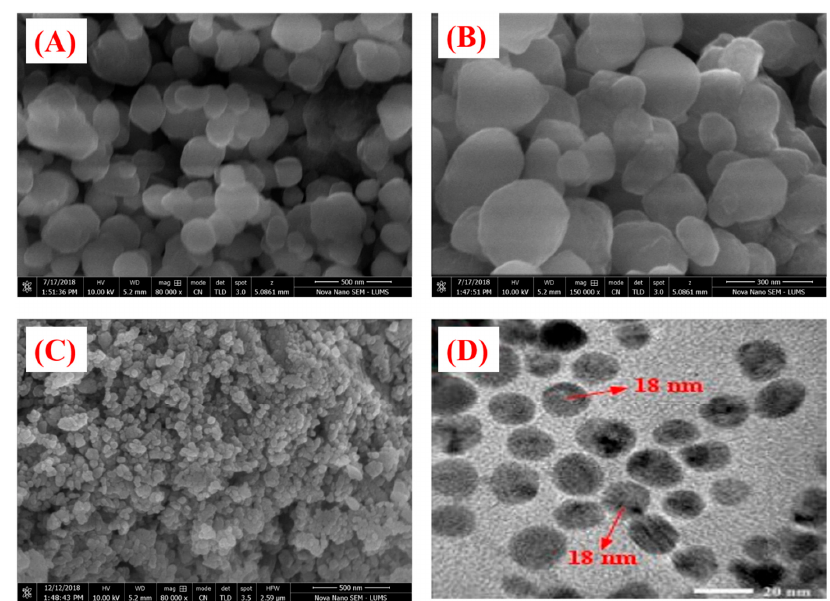
Figure 4. SEM and TEM images of Geranium wallichianum mediated ZnONPs using zinc nitrate as a precursor ( A – C ) HR-SEM images ( D ) TEM image. Biomolecules 2020 , 10 , x FOR PEER REVIEW Table 1. Zeta potential measurements of the ZnONPs.